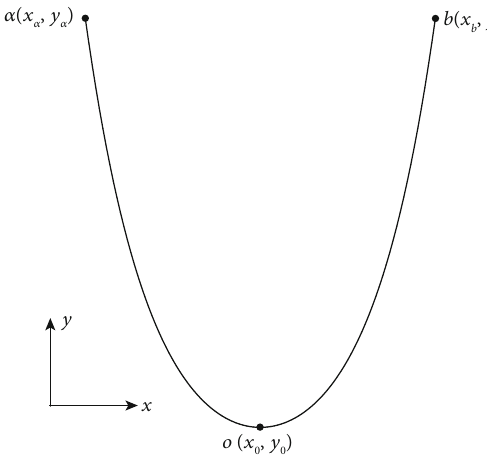
Figure 1: Example of catenary curve. Point a and b are the suspension points. Point o is the